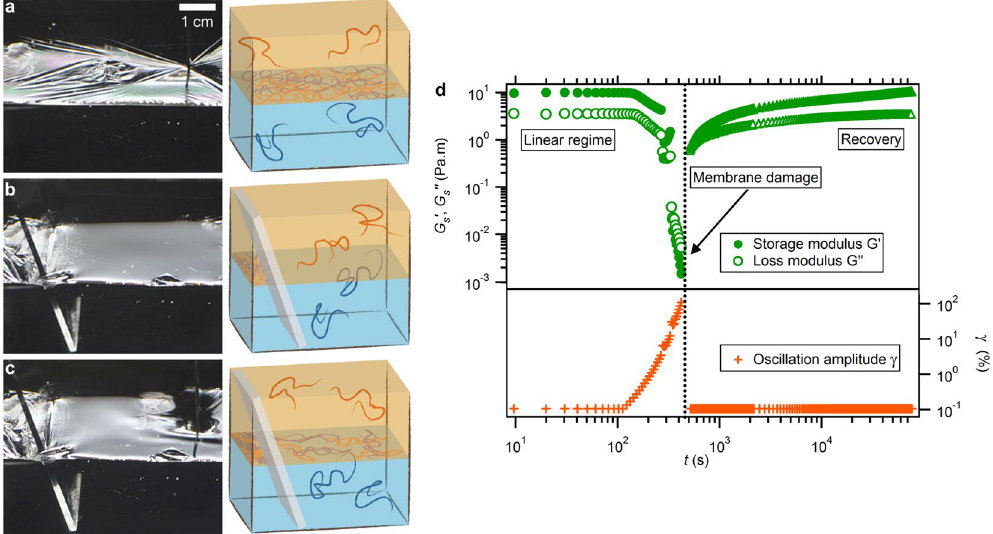
Figure 2. Self-healing process. ( a–c ) Polymer membranes formed at the oil (orange) - water (blue) interface. ( a ) Membrane formed during 15 hours for which a soft contact reveals a lot of wrinkles. ( b ) The membrane is destroyed and pushed side-way with a glass slide. ( c ) Wrinkles on the right of the image indicate that a new membrane is instantaneously formed. ( d ) Storage and loss moduli as a function of time: after a damage due to an increase of the oscillation amplitude, the membrane recovers its viscoelastic properties in the low-amplitude (“linear”) regime. Error bars are shown when larger than markers